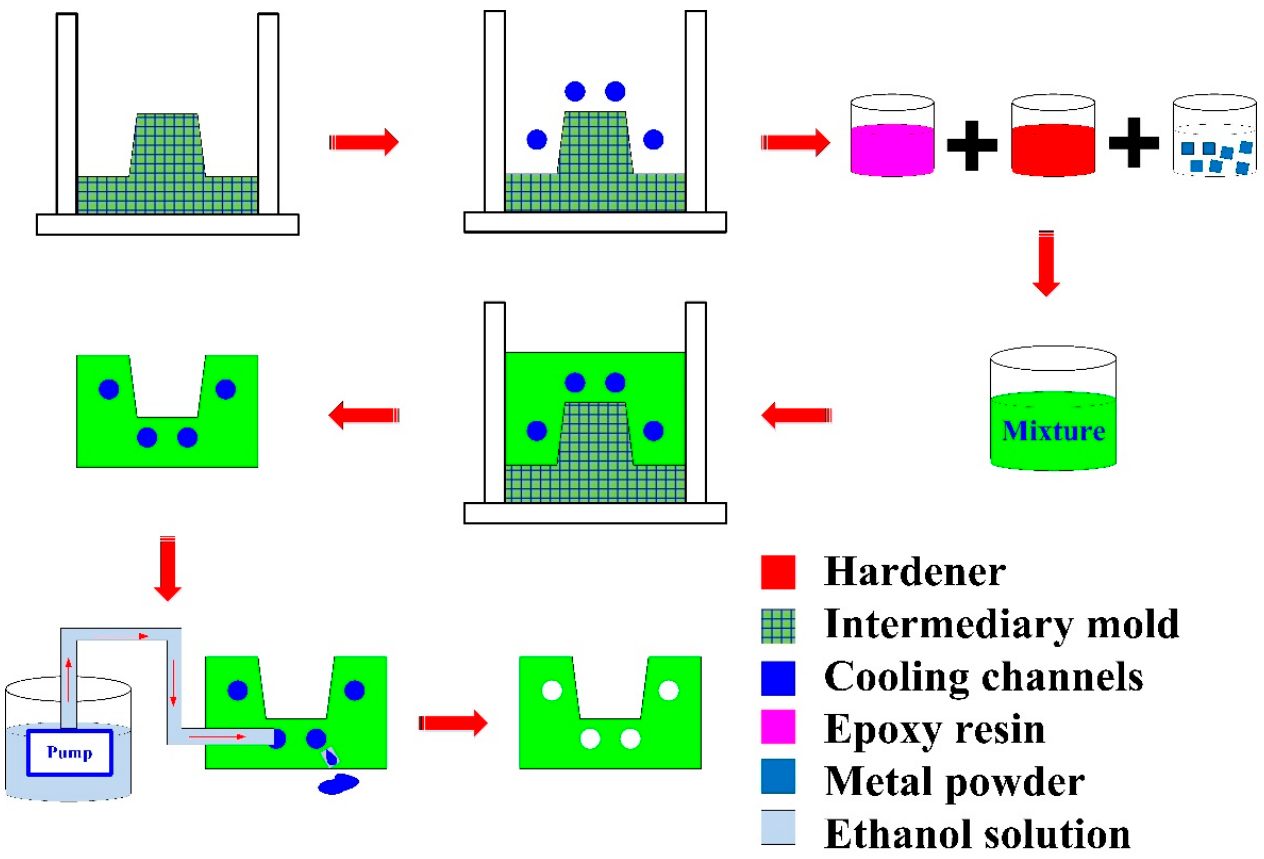
Figure 8. Schematic illustrations of the production process of the wax injection molding tool with cooling channel. Table 2. Main numerical modeling parameters used in the numerical analysis.